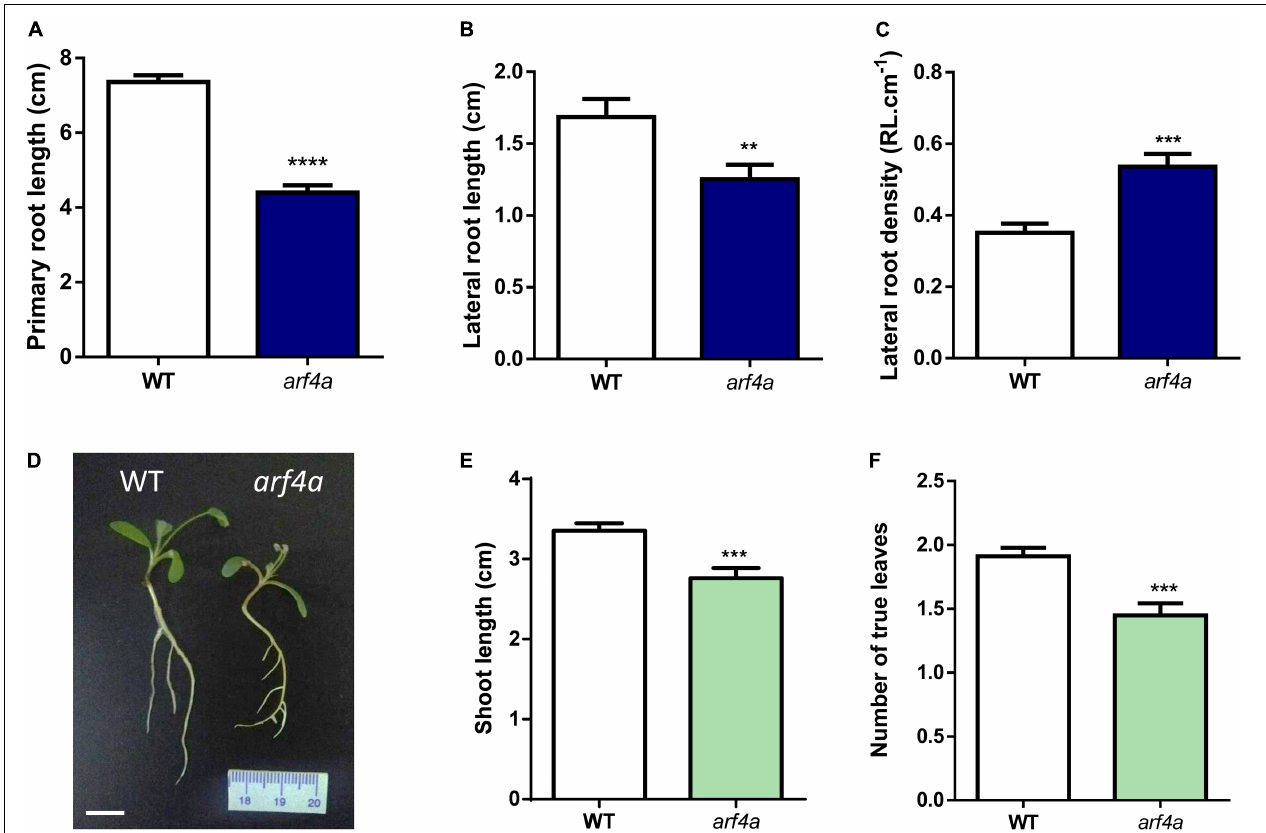
FIGURE 8 | The arf4a mutant exhibited altered root and shoot development. (A–C) Primary root length (A) , lateral root length (B) , and lateral root density (C) were measured in WT and arf4a mutant plants at 7 days after germination (dag). Plants were grown on slanted agar-Fahraeus medium supplemented with 8 m M KNO 3 . Error bars represent mean ± SE of three biological replicates, each with at least 10 plants. Asterisks denote statistically significant differences between WT and arf4a plants in an unpaired two-tailed Student’s t test ( ∗∗ p ≤ 0.01, ∗∗∗ p ≤ 0.001, and ∗∗∗∗ p ≤ 0.0001). (D) Image of WT and arf4a mutant plants at 7 dag illustrating the shorter primary and lateral roots observed in arf4a mutant roots. Scale bar: 1 cm. (E,F) Shoot length (E) and number of true leaves (F) measured in WT and arf4a mutant at 7 dag. Plants were grown on slanted agar-Fahraeus medium supplemented with 8 mM KNO 3 . Error bars represent mean ± SE of three biological replicates, each with at least 10 plants. Three asterisks denote a statistically significant difference between WT and arf4a plants in an unpaired two-tailed Student’s t with a p value ≤